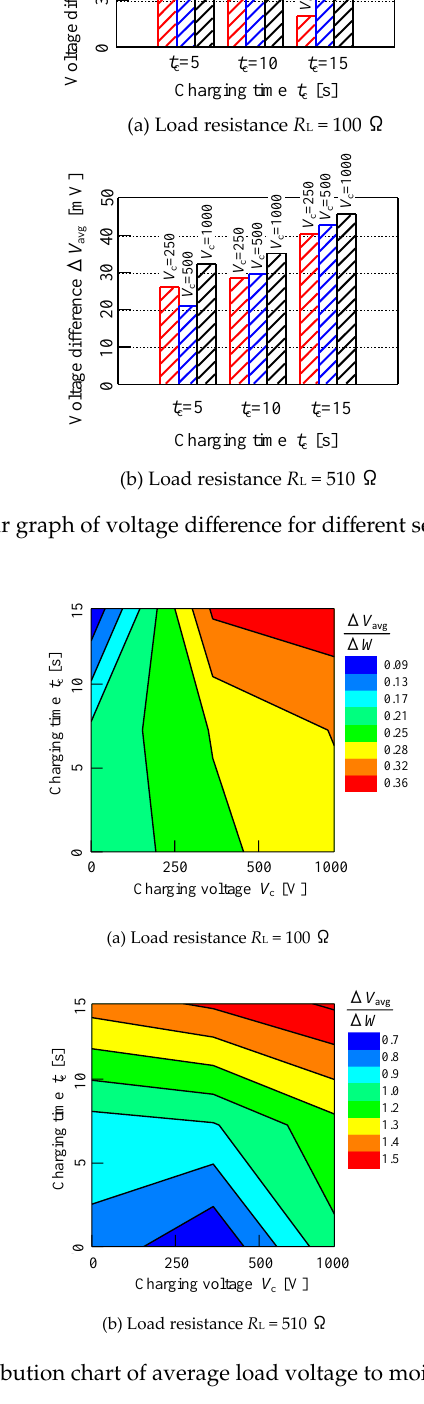
Figure 12. Distribution chart of average load voltage to moisture content ratio.